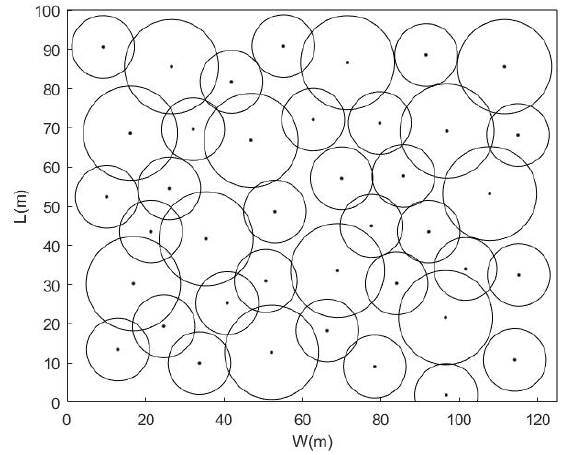
Figure 9. Nodes after VORCP patching.